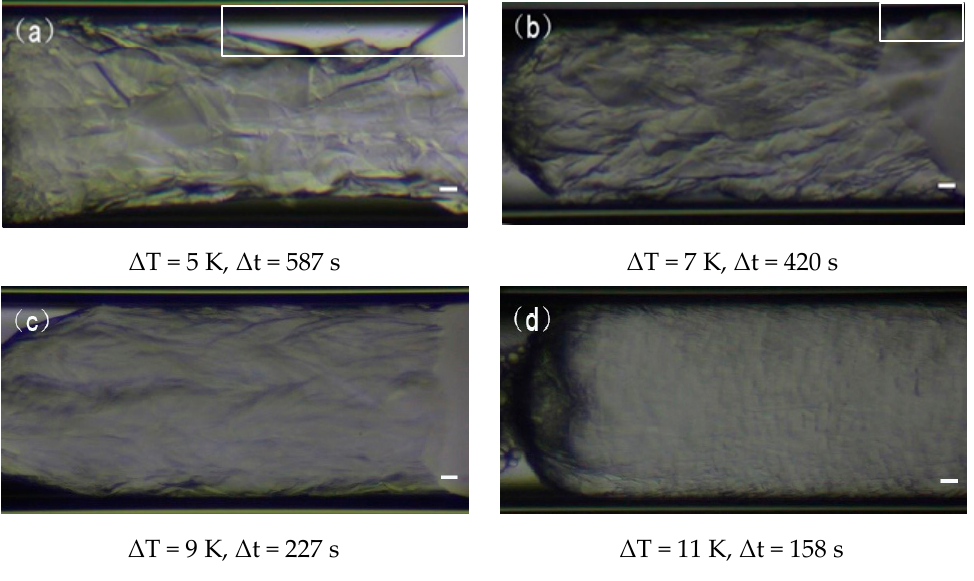
Figure 7. The influence of the supercooling degree on the CP hydrate halo grown to a similar length ( ≈ 985 μ m). The scale bars in the images correspond to 50 μ m.